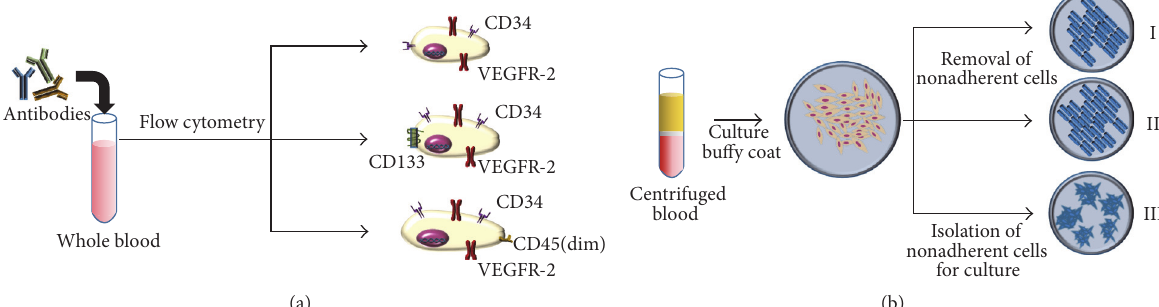
Figure 2: Definition of endothelial progenitor cells (EPCs). (a) Flow cytometry: analysis of whole blood samples by flow cytometry utilizing various combinations of antibodies tagged with fluorophores raised against surface antigens such as CD34+/VEGFR-2+, CD34+/VEGFR- 2+/CD133+, or CD34+/VEGFR-2+/CD45(dim) to isolate populations. (b) Culture assay: obtained via Ficoll-based centrifugation of whole blood to isolate and culture the buffy-coat layer composed of peripheral blood mononuclear cells (PBMCs). I and II use adherent cells after removal of nonadherent cells. I, EPCculture on fibronectin plate; II, culturing thesecells on collagen plate forming endothelial colony forming cells; III, isolation of nonadherent cells for culture to generate colony forming units